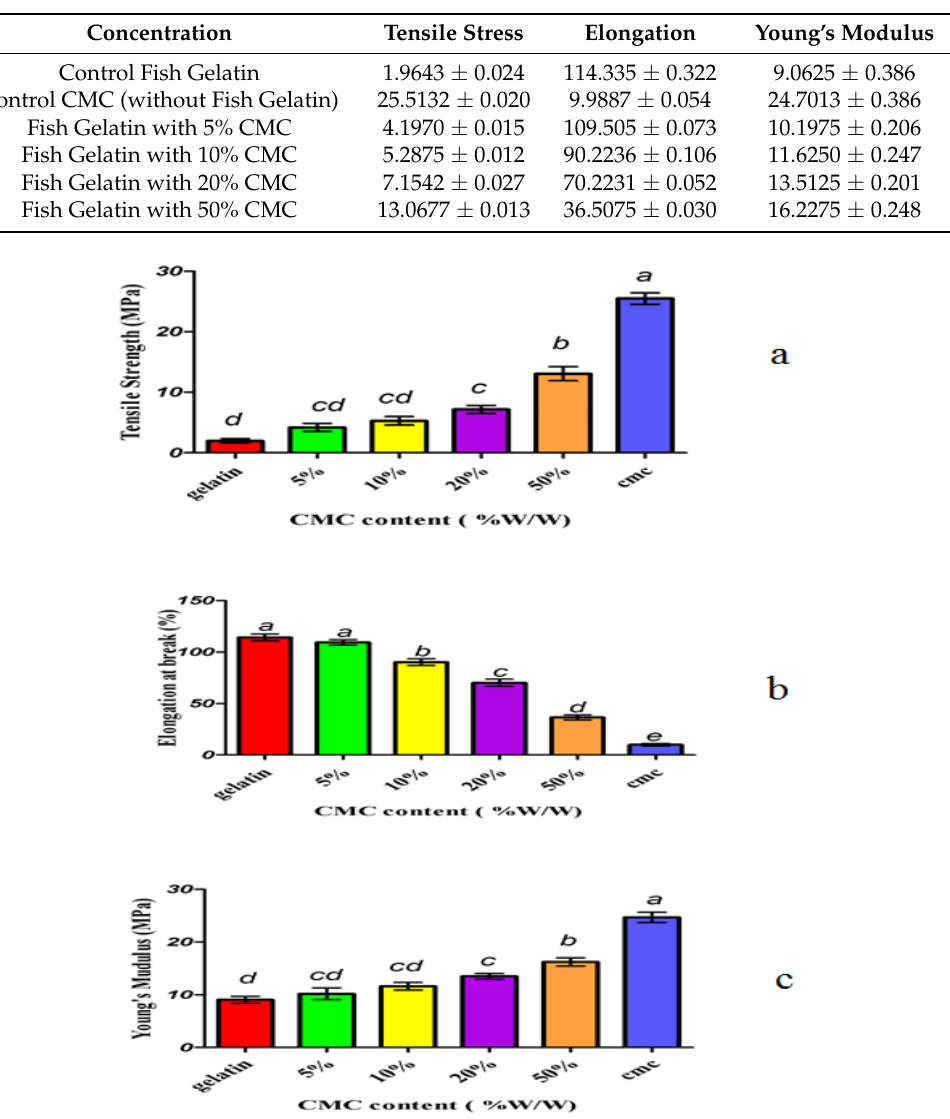
Figure 1. Percent tensile strength diagram (a), elongation diagram (b) and Young’s modulus diagram (c) with different concentrations of Carboxymethyl Cellulose (CMC) in cold water fish gelatin film. Different letters in each column indicate significant differences at the level of statistically 95% ( p <